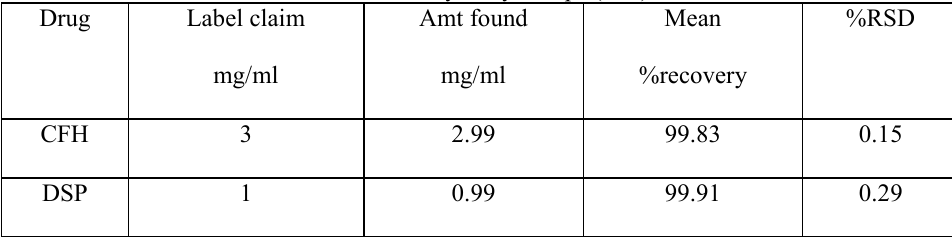
Table 5. Assay of eye drops